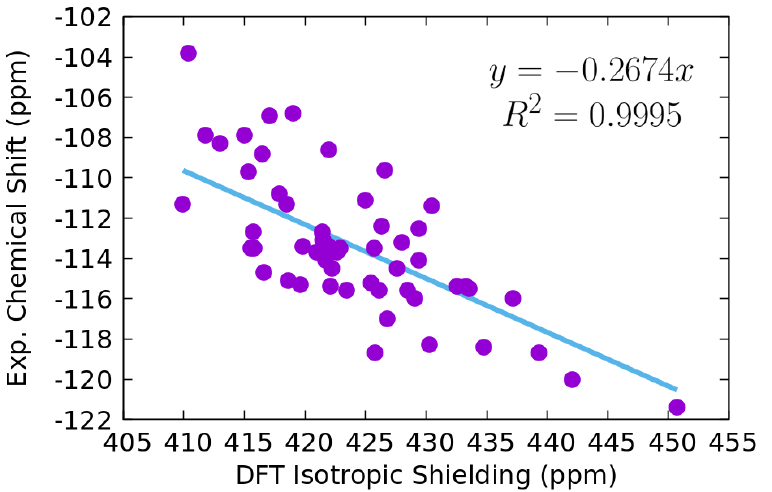
Figure 1. Comparison between DFT isotropic shielding and experimental chemical shift (both in ppm) alongside the linear fitting of the data (blue line).